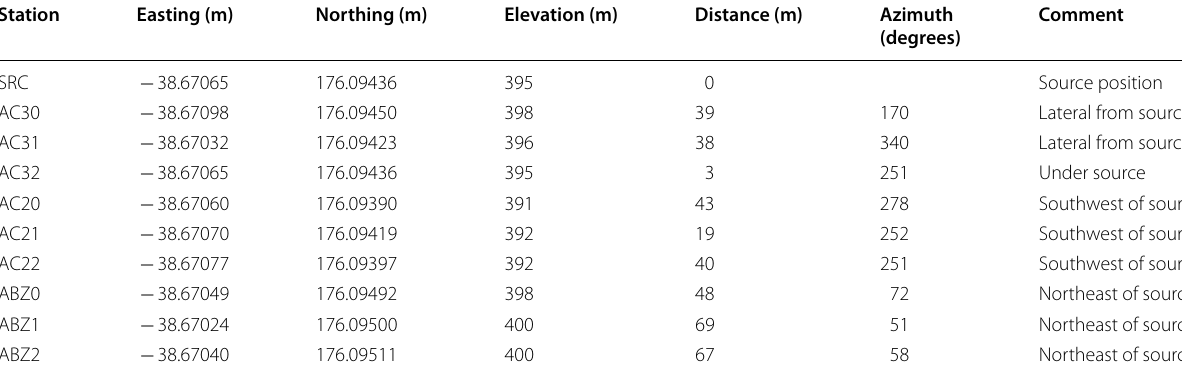
Table 2 Station and cannon (SRC) latitude and longitude locations given in decimal degrees Station